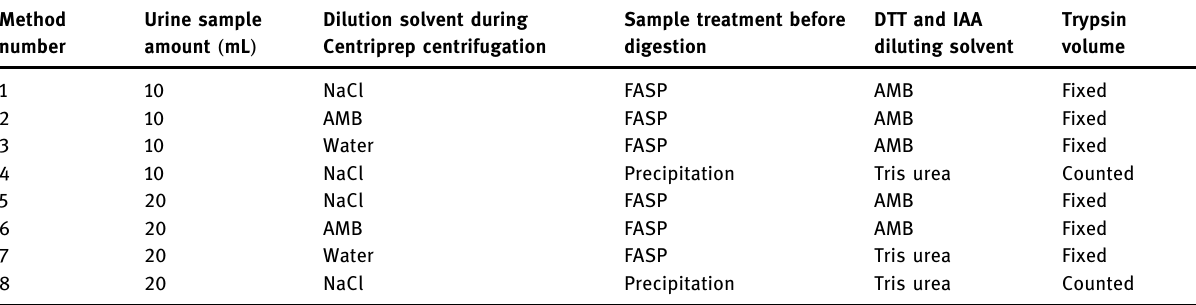
Table 1: Summary of the di ff erent protein isolation processes used in the method optimisation